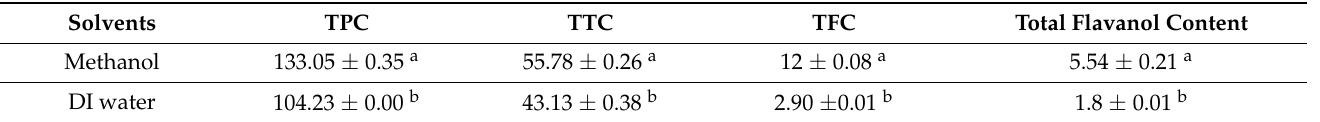
Table 2. TPC, TTC, TTFC, and total flavanol content of A. garckeana fruit (mg/g